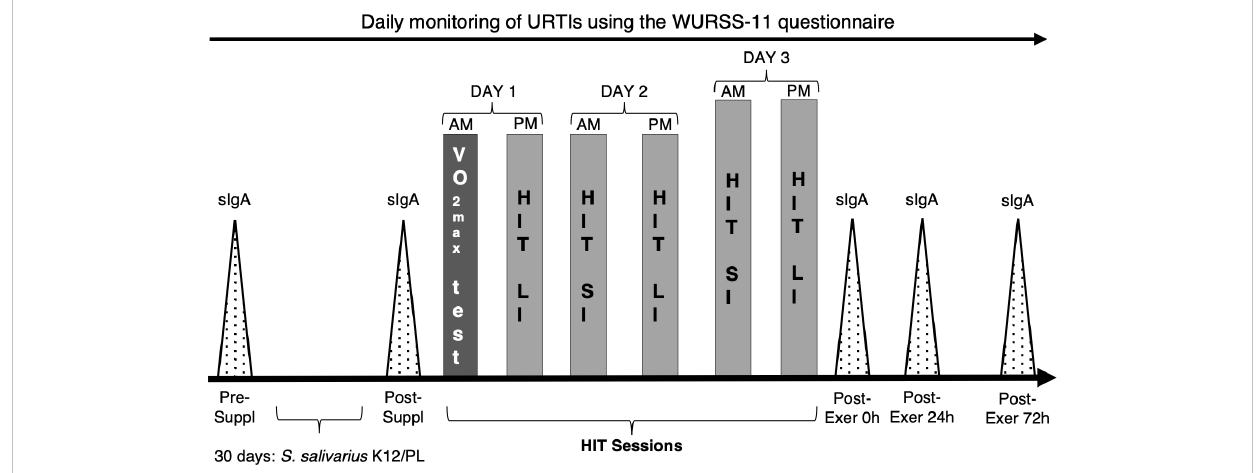
FIGURE 1 Experimental design. S. salivarius K12: S. salivarius supplement; PL: placebo compound; sIgA: salivary test sessions of immunoglobulin A; Pre-Suppl: salivary tests before S. salivarius K12/PL supplementation; 30 days: S. salivarius K12/PL: period of S. salivarius K12 or PL intake; Post-Suppl: salivary tests after S. salivarius K12 or PL intake; Post-Exer 0h-24h and 72h: salivary tests immediately after training sessions, after 24 and after 72h. AM, morning session; PM afternoon session. VO 2max test session; HIT LI: long intervals of high-intensity training; HIT SI: short intervals of high-intensity